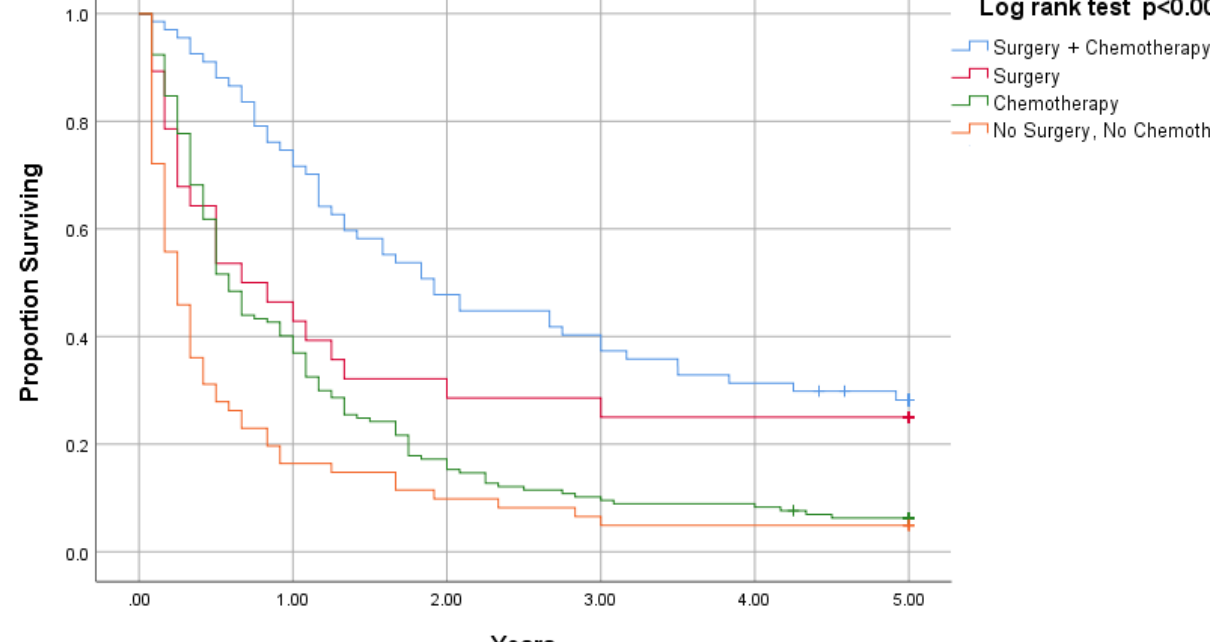
Table 3. Cox’s proportional hazards analysis according to potential prognostic factors for 5-year survival of malignant pleural mesothelioma. Variables